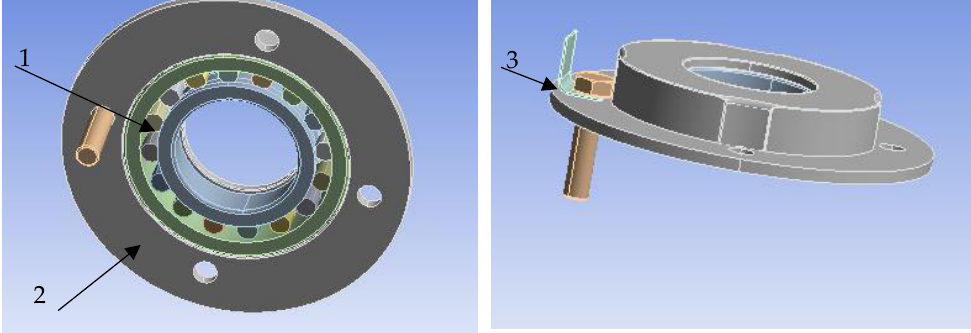
Table 1. Material properties.